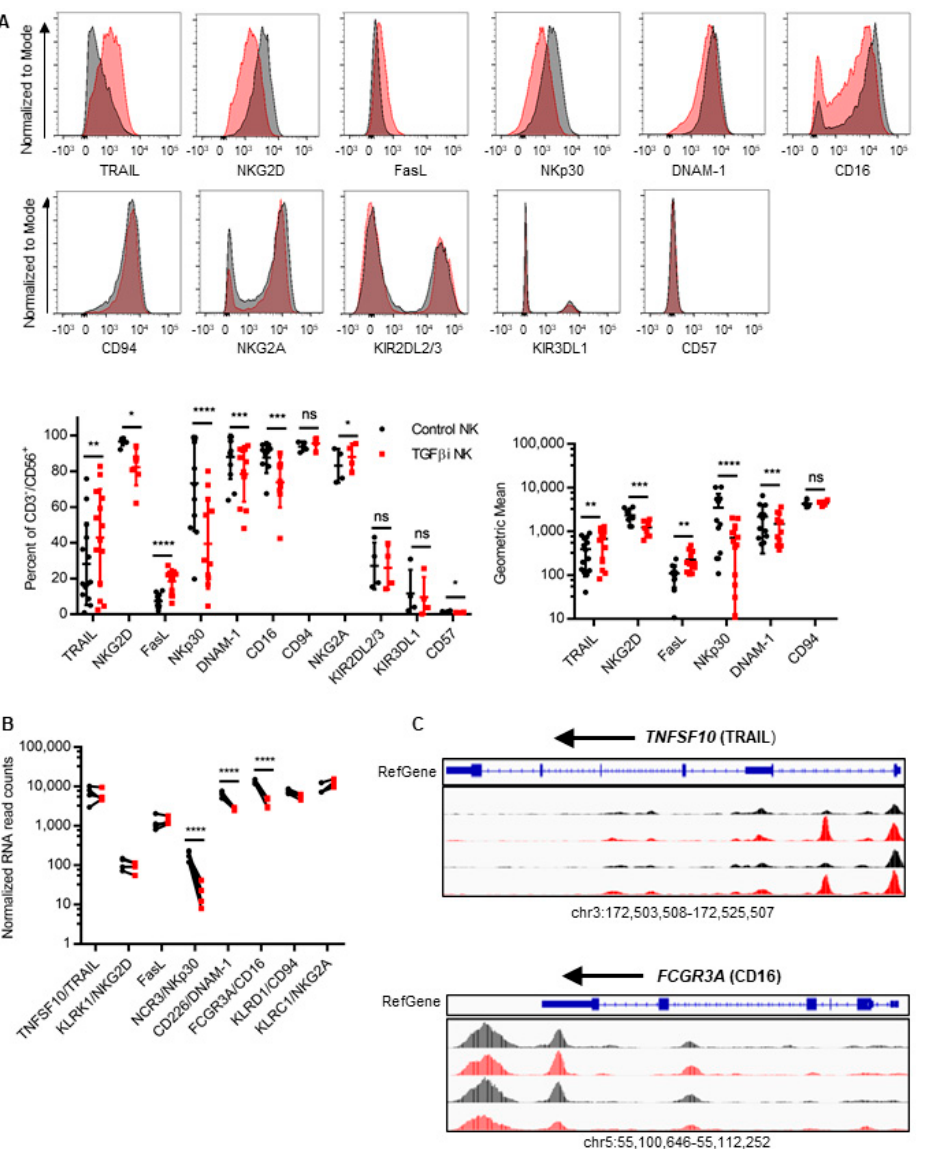
Figure 4. TGF β i remodels K562mbIL-21 expanded NK cell receptor expression. ( A ) Cell surface protein expression on the control and TGF β i NK cells was measured using flow cytometry. Geometric median fluorescent intensity (gMFI) normalized to viability only stained NK cells are shown. Flow data from one representative donor is depicted. Control in black, TGF β i in red. ( B ) mRNA expression of NK cell receptors was assessed by RNA-seq ( n = 4). ( C ) Chromatin accessibility of TNSF10 and FCGR3A was determined at Day 14 using ATAC-seq. Control in black, TGF β i in red. Individual Data points depicted. Lines and bars represent Mean ± SD. Statistical differences were determined by paired t -test and DESeq2 for RNA-seq. * p ≤ 0.05, ** p ≤ 0.01, *** p ≤ 0.001, **** p ≤ 0.0001. See also Figures S4 and